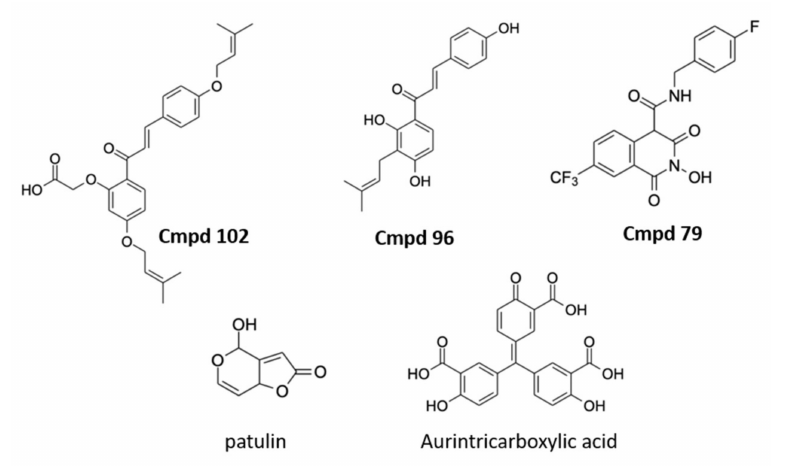
Figure 3. Representative non-nucleoside NSP14 inhibitors. Compounds 102 (IC 50 : 19.4 µ M), 96 (IC 50 : 17.4 µ M), and 79 (IC 50 : 22.0 µ M) described in [72], and patulin (IC 50 : 1.8 µ M) and aurintricarboxylic acid (IC 50 : 10.3 µ M) described in